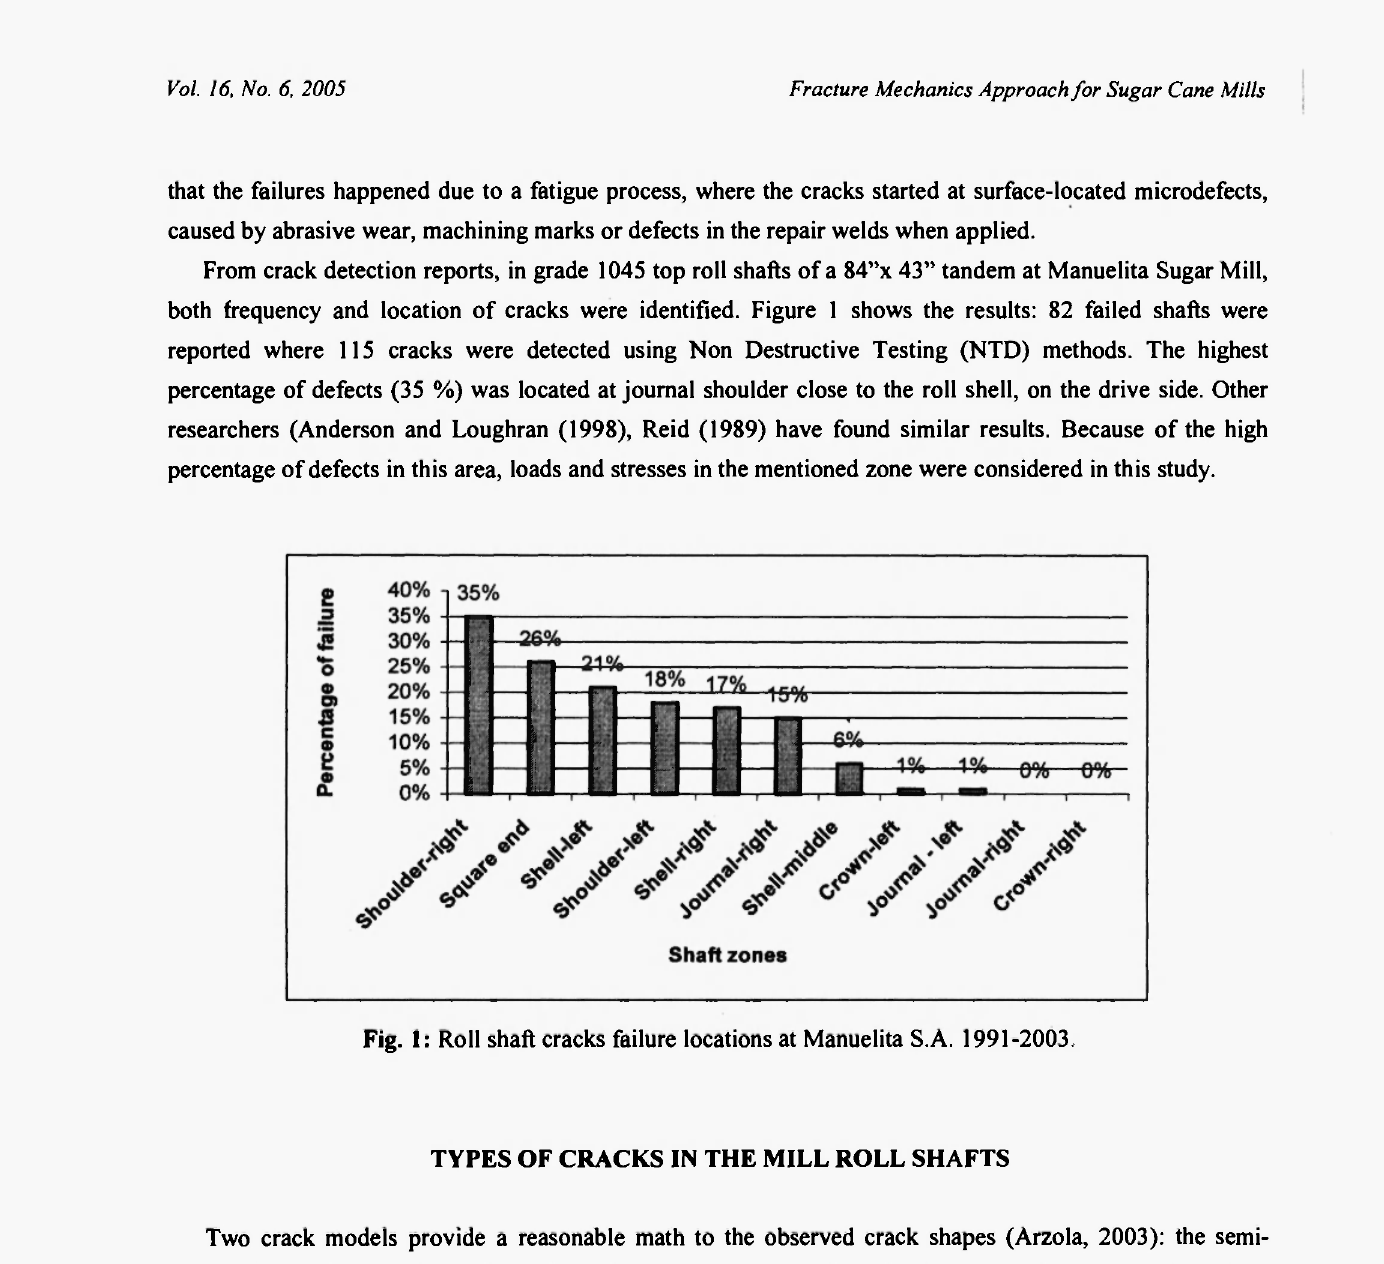
Fig. 1: Roll shaft cracks failure locations at Manuelita S.A.